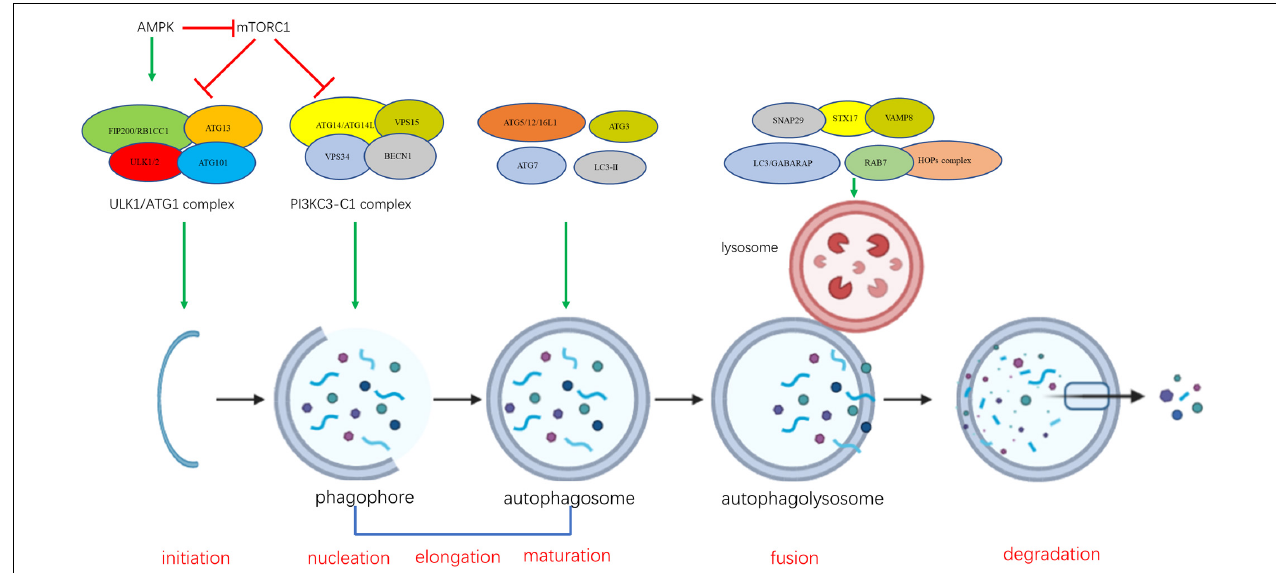
FIGURE 1 | The sequential steps of autophagy involve the participation and interaction of the ATG proteins.